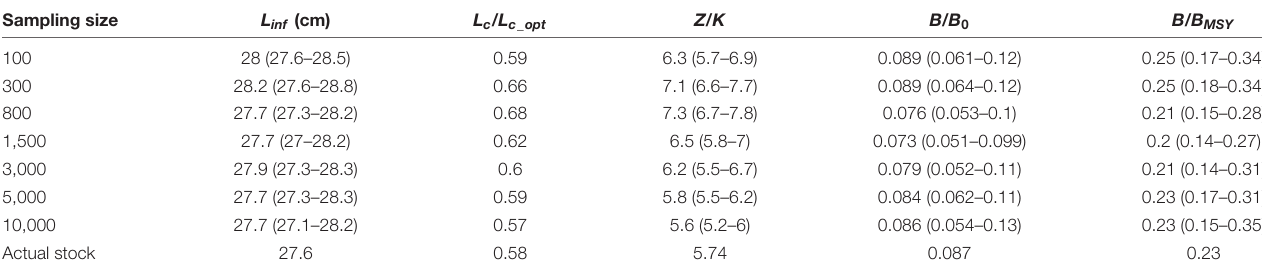
The numbers between brackets represent 95% credible intervals for the parameters. TABLE 4 | Estimated parameters of the LBB for a range of sample sizes for a simulated data series from Zhang K. et al. (2020). Sampling size L inf